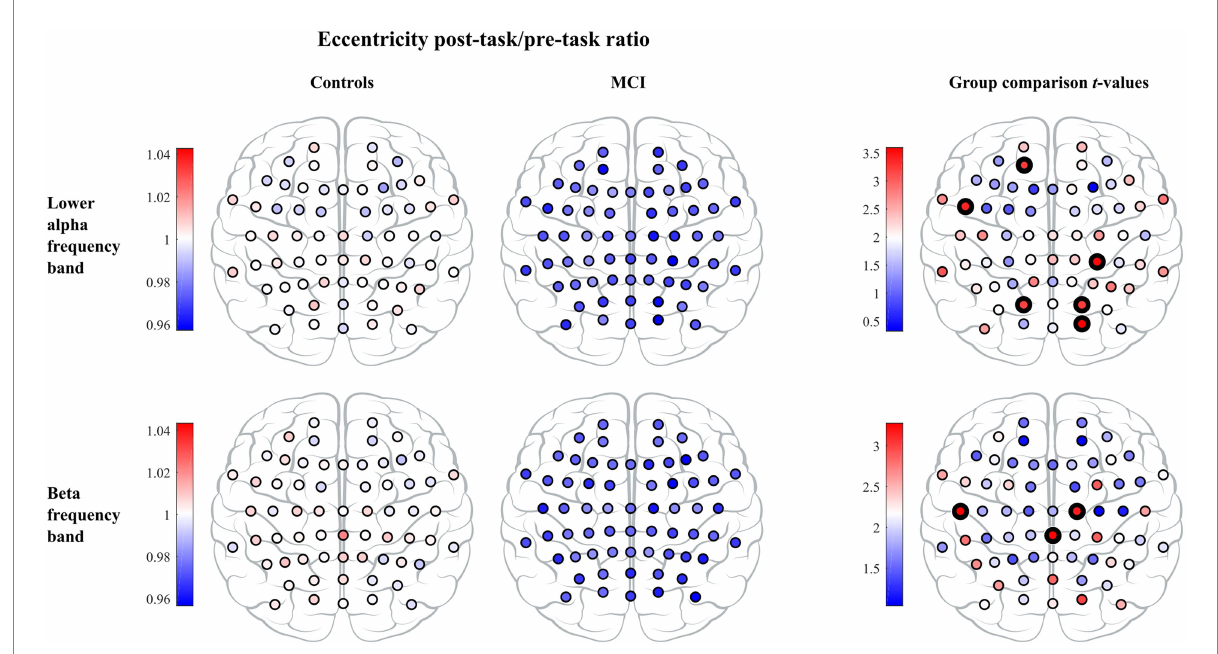
FIGURE 4 The vertex eccentricity post-task/pre-task ratio across lower alpha and beta frequency bands for controls (left column) and MCI patients (middle column). Statistics on the vertex eccentricity post-task/pre-task ratio showed significant differences between the two groups and are shown in the right column. Individual vertex t -values are represented with black bolded vertices indicating FWE-corrected p <